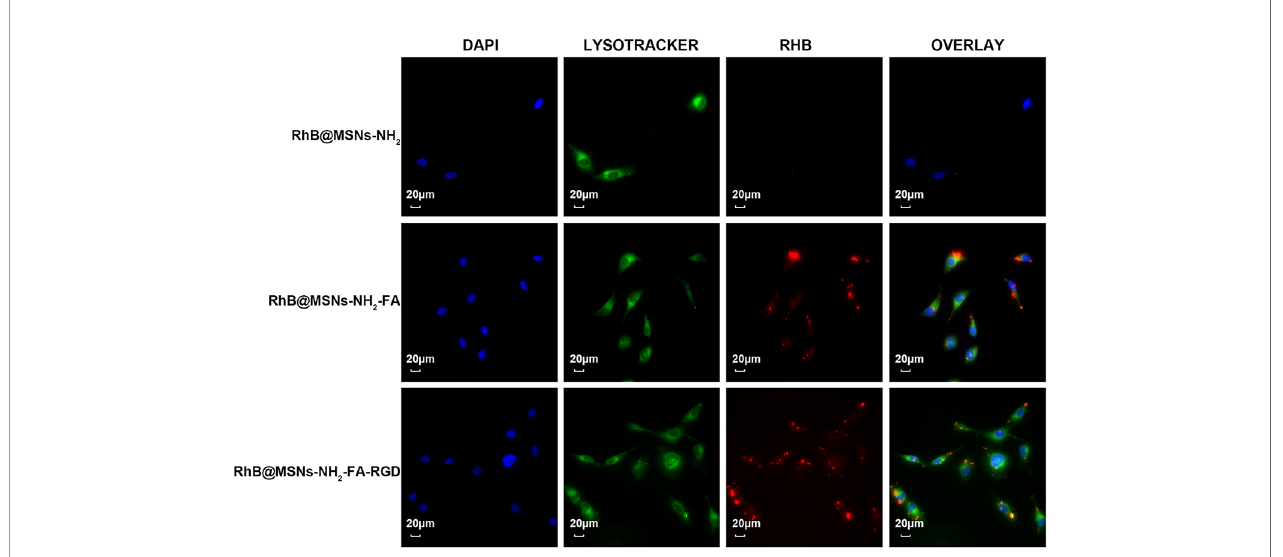
FIGURE 8 | Fluorescence microscopy images of HeLa cells incubation with RhB@MSNs-NH 2 , RhB@MSNs-NH 2 -FA, and RhB@MSNs-NH 2 -FA-RGD for 4 h. Blue fl uorescence fi eld: nucleus; green fl uorescence fi eld: cytoplasm; red fl uorescence fi eld: a dye used to label nanocarriers. Scale bar: 20 m m.